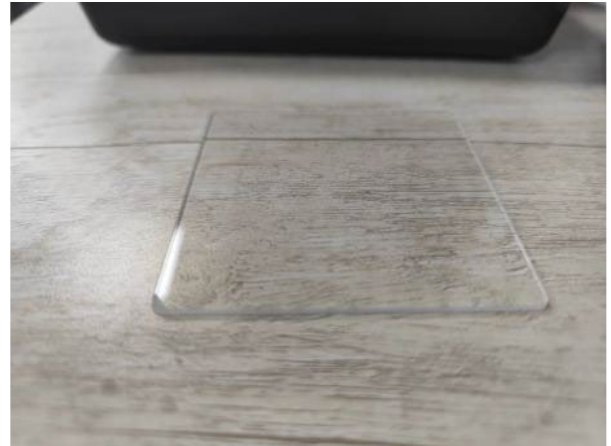
Figure 8. Three-inch photomask glass substrate.